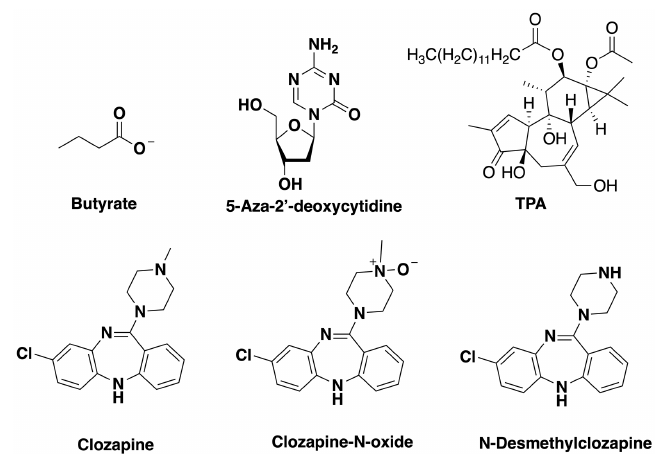
Figure 1. Structures of drugs tested for effects on Epstein-Barr virus (EBV) lytic reactivation: sodium butyrate (NaB), 5-aza-2’-deoxycytidine (dAzaC), 12- O -tetradecanoylphorbol-13-acetate (TPA), clozapine, clozapine-N-oxide, and N-desmethylclozapine.